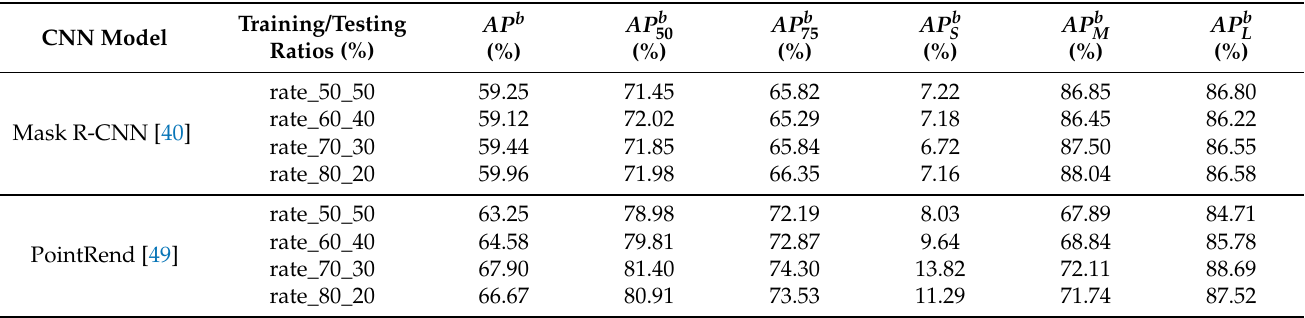
Table 9. The results (%—percent) of human segmentation (box- m ) on the MADS dataset is evaluated on the CNNs. CNN